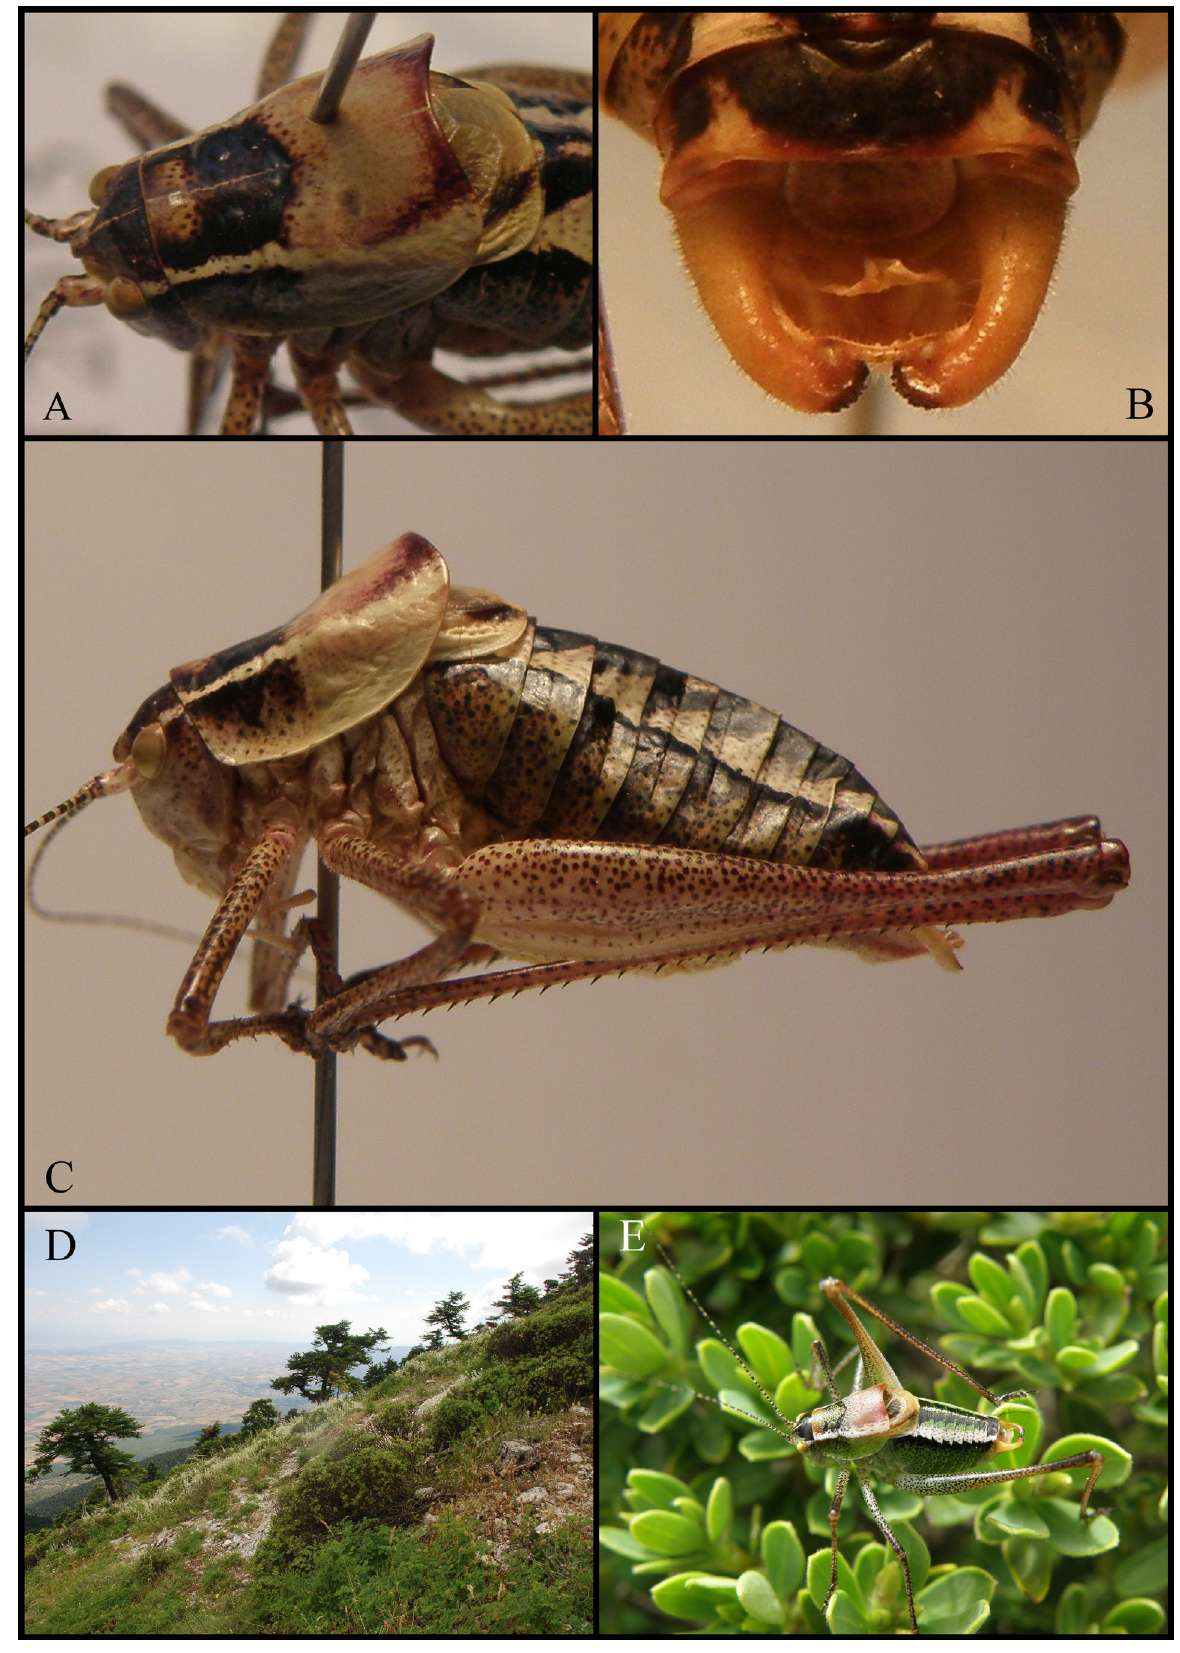
Figure 1. Poecilimon propinquus , Sterea Ellas, Mt. Kitheron, 19 V 2013. A . pronotum, B . tip of abdomen, C . habitus, D . collection locality with scattered bushes of Daphne , E .